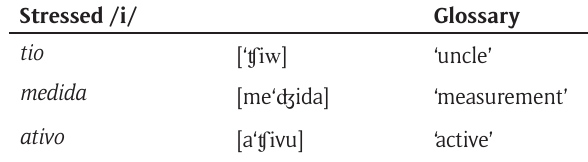
Table 2: Palatalization of /t/, /d/ before stressed /i/.